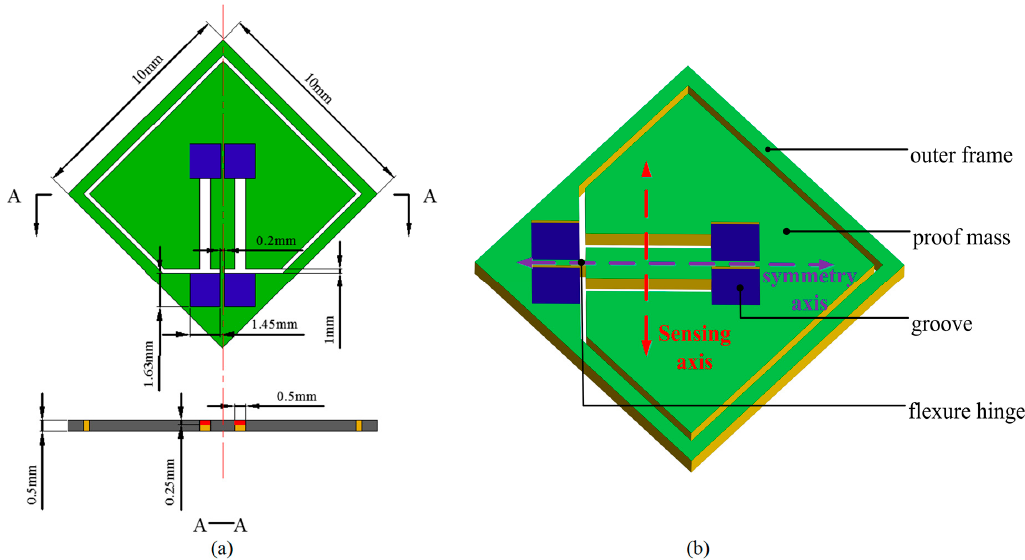
Figure 3. Diagrammatic diagram of silicon substrate: ( a ) front view and cross-sectional view along the A — A; ( b ) structure diagram.